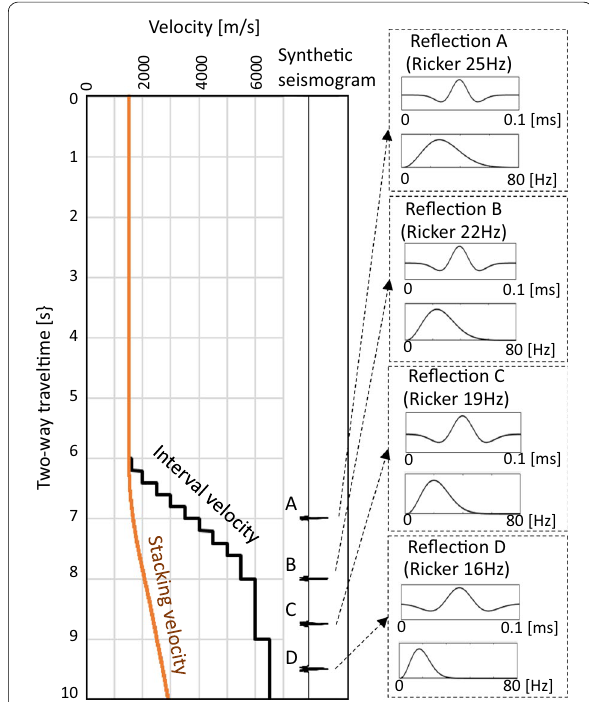
Fig. 7 Velocity model and synthetic seismogram for testing Q esti‑ mation errors caused by frequency distortion associated with NMO stretching. The orange solid curve is the stacking velocity function used for NMO correction. The synthetic seismogram contains four Ricker wavelets of center frequency of 25, 22, 19 and 16 Hz